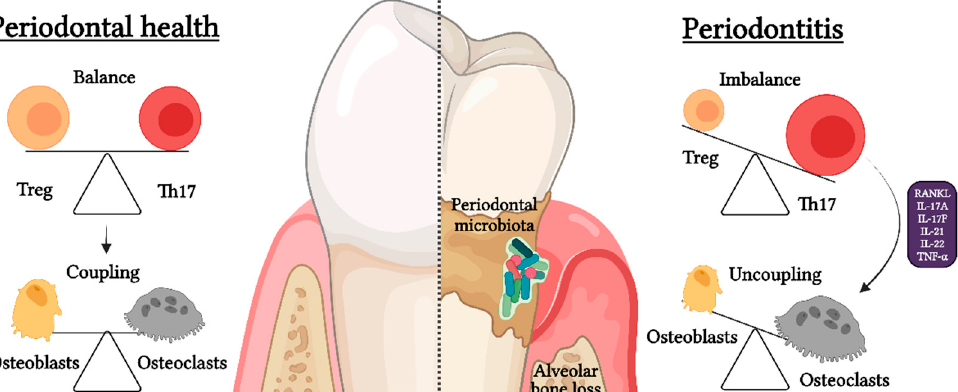
Figure 4. Th17/Treg imbalance during periodontitis. During periodontal health, there is a balance between the Th17- and Treg-pattern of the immune response, which determines the molecularly mediated cellular coupling between osteoclasts and osteoblasts and thus the consequent physiological process of bone remodeling. However, during periodontitis, there is a Th17/Treg imbalance that favors the Th17-pattern of immune response and leads to osteoclast/osteoblast uncoupling. Remark- ably, this Th17/Treg imbalance provokes an increased differentiation and activation of osteoclast caused by the production of elevated levels of pro-osteoclastogenic mediators, such as receptor– activator of NF- κ B ligand (RANKL), interleukin (IL)-17A, IL-17F, IL-21, IL-22, and tumor necrosis factor (TNF)- α , which finally lead to irreversible tooth-supporting alveolar bone loss. Th17 lymphocytes express the following master-switch transcription factors: signal